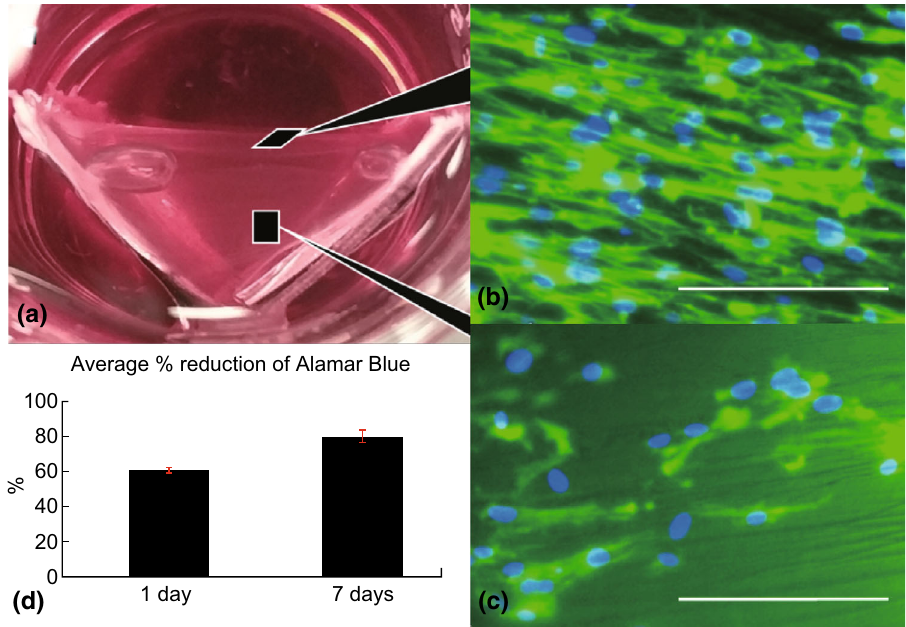
Fig. 10 a A cell-seeded nanofiber scaffold in culture medium. Fluorescence images of fibroblasts from the b top and c side view of the scaffold. Scale bar = 200 l m. Blue: nucleus; green: cytoplasm. d Average percentage reduction of alamar Blue dye after day 1 and 7. (Color figure